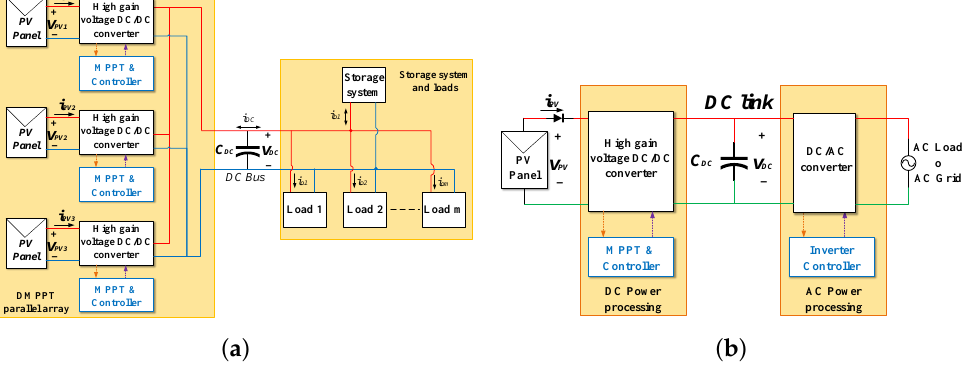
Figure 1. High gain voltage DC/DC converters applications. ( a ) DMPPT parallel in a DC microgrid; ( b ) Microinverter scheme for PV